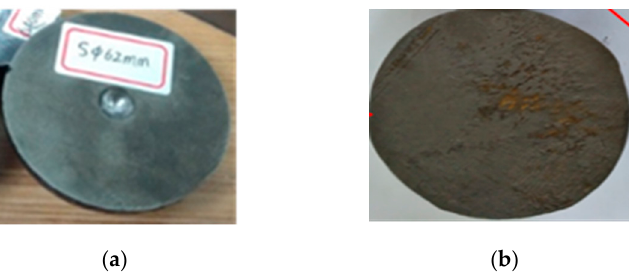
Figure 14. Comparable analysis of void closure in the core of specimen. ( a ) before floating pressure; ( b ) after floating pressure.